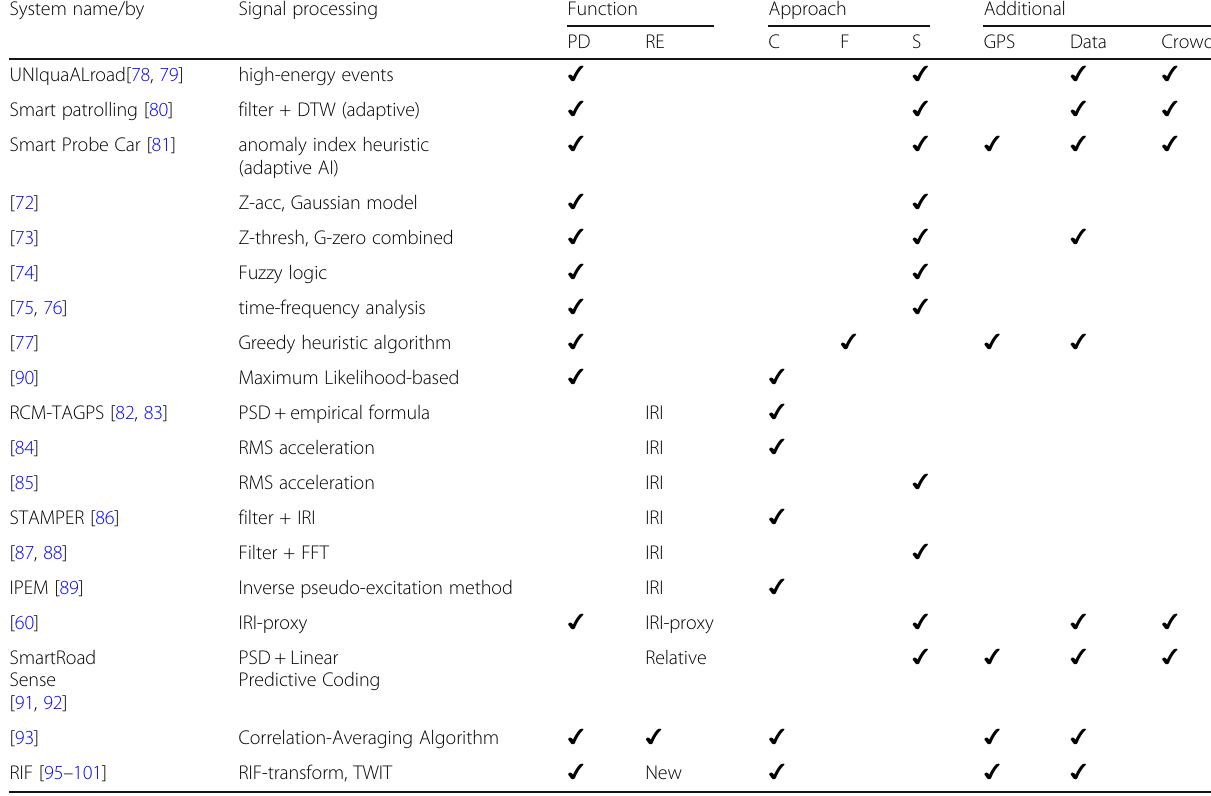
Table 5 Summary of signal processing methods for pothole detection and roughness index estimation System